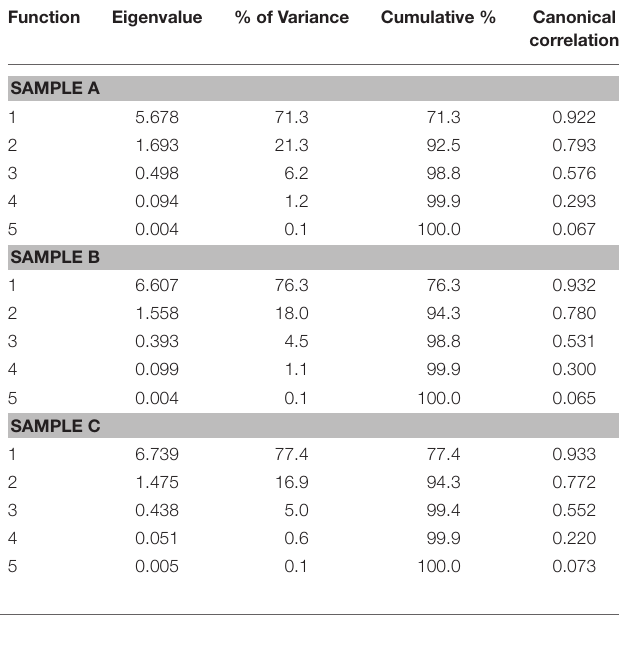
TABLE 5 | Discriminant functions for Sample A ( n = 2,364), Sample B ( n = 2,303), and Sample C ( n = 1,865). Function Eigenvalue % of Variance